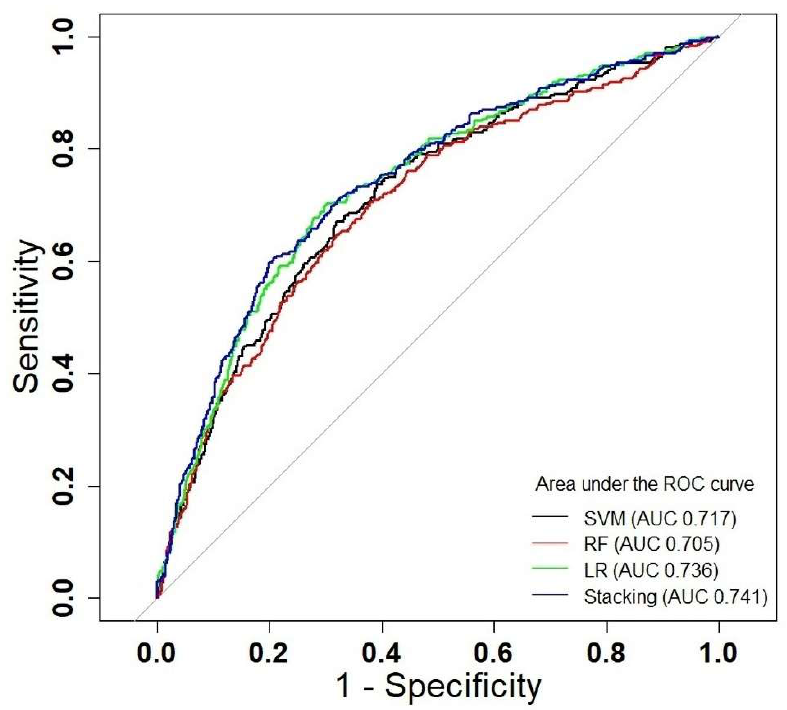
Figure 4. Evaluation of the predictive ability of non-fatal drowning prediction models based on the test dataset. Area under average ROC curve 0.741 (stacking), 0.736 (LR), 0.717 (SVM), and 0.705 (RF).